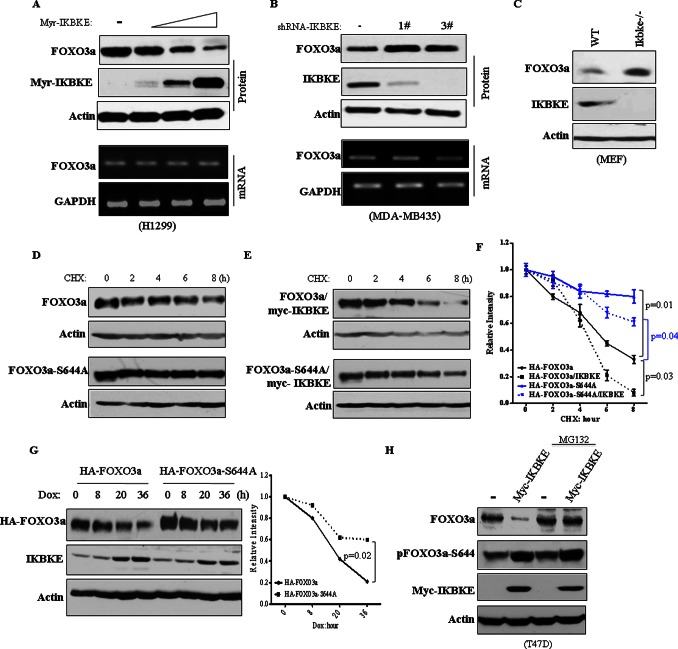
IKBKE phosphorylation of FOXO3a-S644 induces FOXO3a degradation.(A) Expression of constitutively active IKBKE reduces FOXO3a expression at protein but not mRNA levels. H1299 cells were transfected with an increasing amount of myr-IKBKE and subjected to immunoblot (upper panels) and RT-PCR (lower panels) analysis. (B) Knockdown of IKBKE increases FOXO3a protein levels. Two IKBKE-shRNAs were introduced into MDA-MB435 cells. Following incubation for 72 h, immunoblot (upper panels) and RT-PCR (lower panels) analyses were performed. (C) Immunoblot analysis of wild-type and Ikbke-knockout MEFs with indicated antibodies. (D–F) IKBKE induces FOXO3a protein degradation which depends on phosphorylation of Ser644. H1299 cells were transfected with FOXO3a or FOXO3a-S644A together with and without IKBKE. After 48 h of transfection, cells were treated with CHX for different times and then were immunoblotted with indicated antibodies (D and E). Degradation rates of FOXO3a and FOXO3a-S644A in the presence and absence of IKBKE were quantified (F). (G) IKBKE induces FOXO3a degradation more significantly than FOXO3a-S644A in IKBKE tet-on cells. The IKBKE tet-on HeLa cells were transfected with FOXO3a and FOXO3a-S644A. After 48 h of transfection, cells were treated with doxycycline for indicated times and then immunoblotted with indicated antibodies. (H) IKBKE-induced FOXO3a degradation was inhibited by proteasome inhibitor. T47D cells were transfected indicated plasmids, treated with and without MG132 and then were immunoblotted with indicated antibodies.